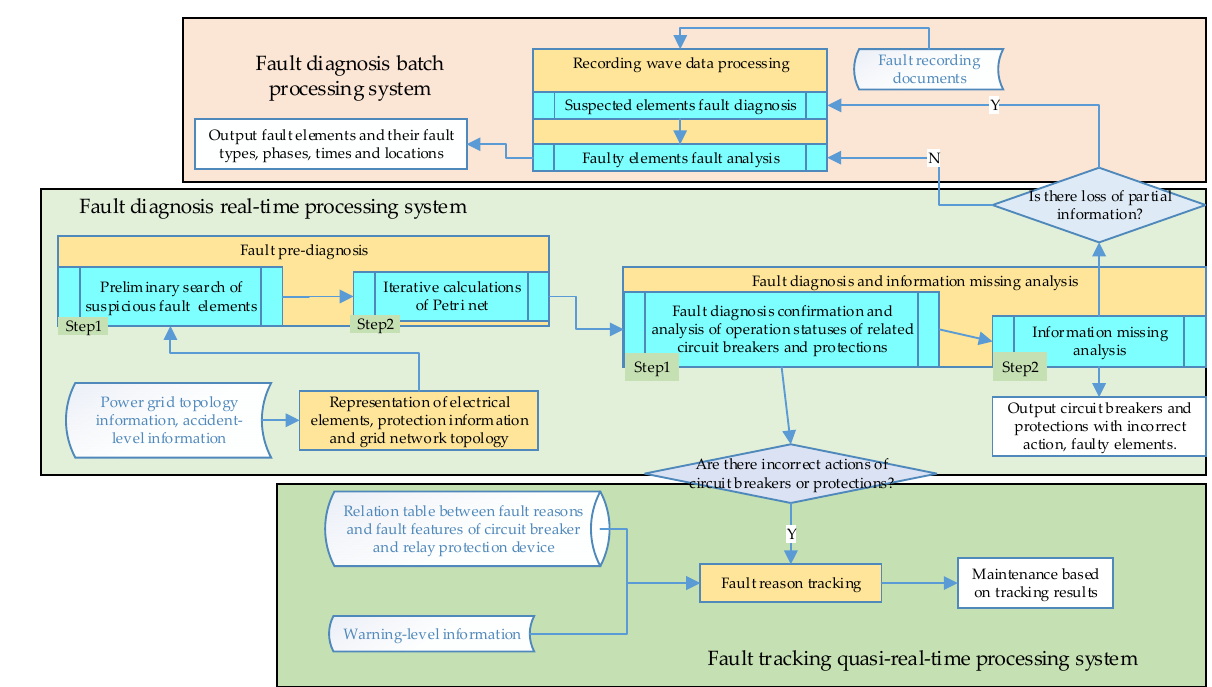
Figure 1. System framework.